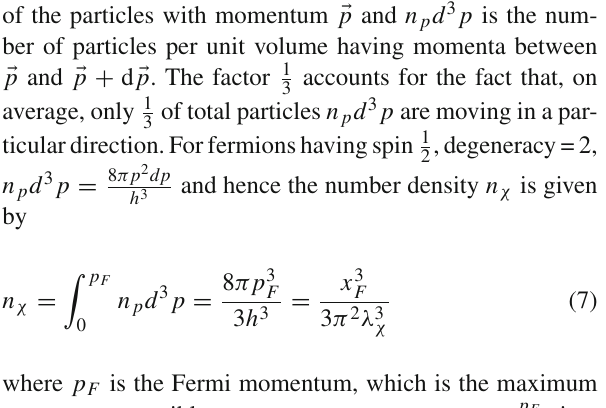
Fig. 1 Massvs.centralbaryonicdensityplotofslowlyrotatingneutron stars for the DDM3Y EoS